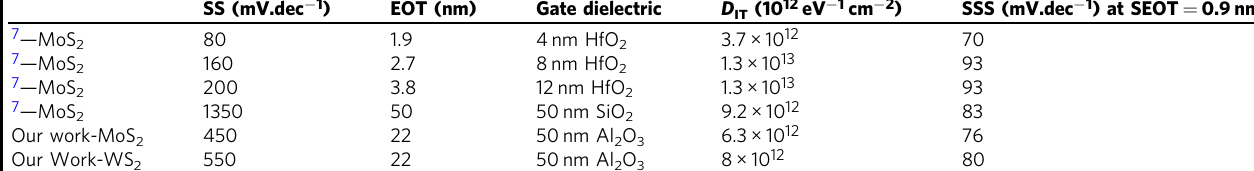
Table 2 Benchmarking median subthreshold slope for L CH = 100 nm.